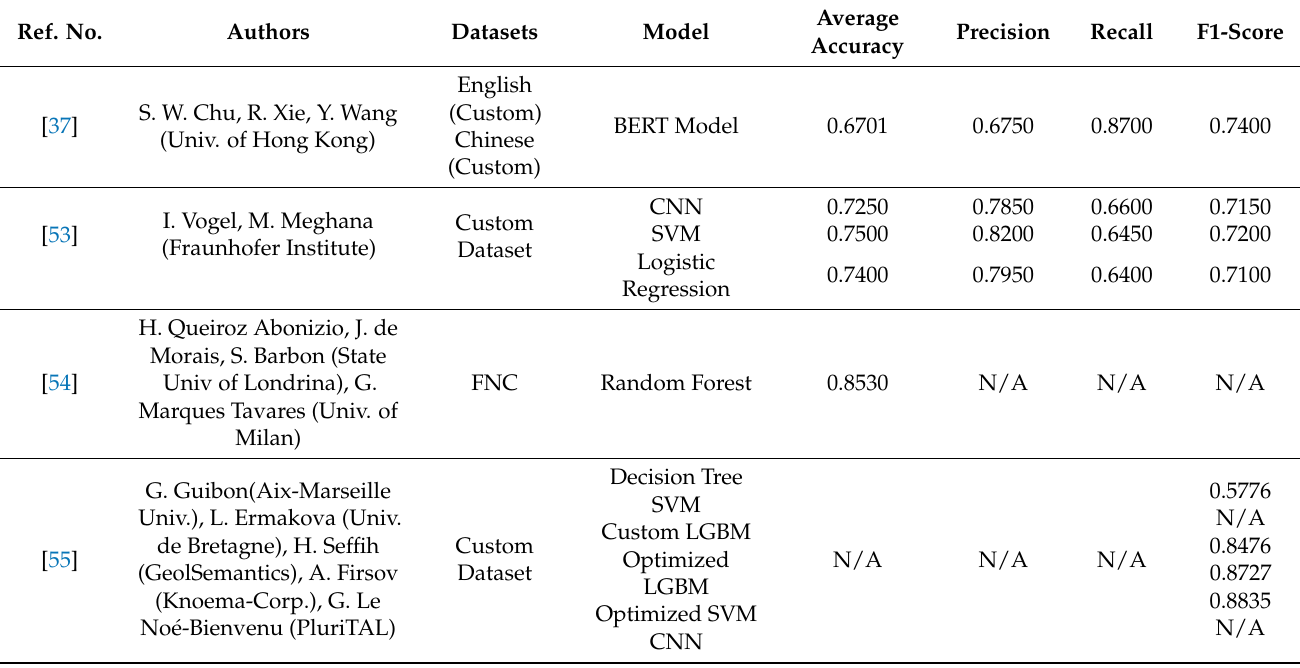
Table 8. Performance Evaluation of Cross-Language Methodologies.